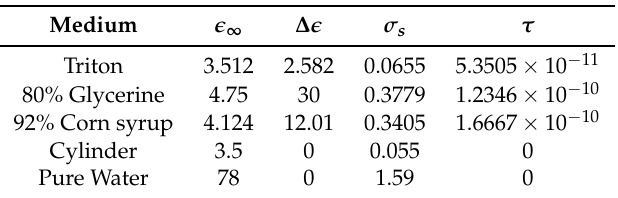
Table 1. Debye parameters for the considered immersion liquids (derived by experimental measurements and data fitting in the range 1.0–3.0